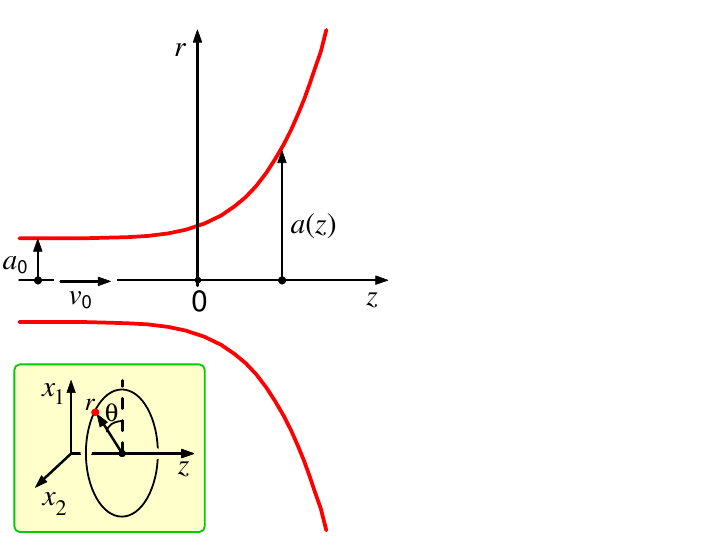
Figure 2. The thread/droplet transition region; r = a ( z ) defines the free surface in cylindrical coordinates ( z , r , θ ) ; a 0 and v 0 are the thread radius and the flow velocity at the end of the uniform thread region. Note that a longitudinal cross-section including the cylindrical symmetry axis ( z ) is shown here. Thus, the upper curve corresponds to the cylindrical angle θ = 0, the lower curve to θ = 180 ◦ , and the r -axis coincides with the Cartesian x 1 -axis. The inset clarifies the cylindrical coordinates used